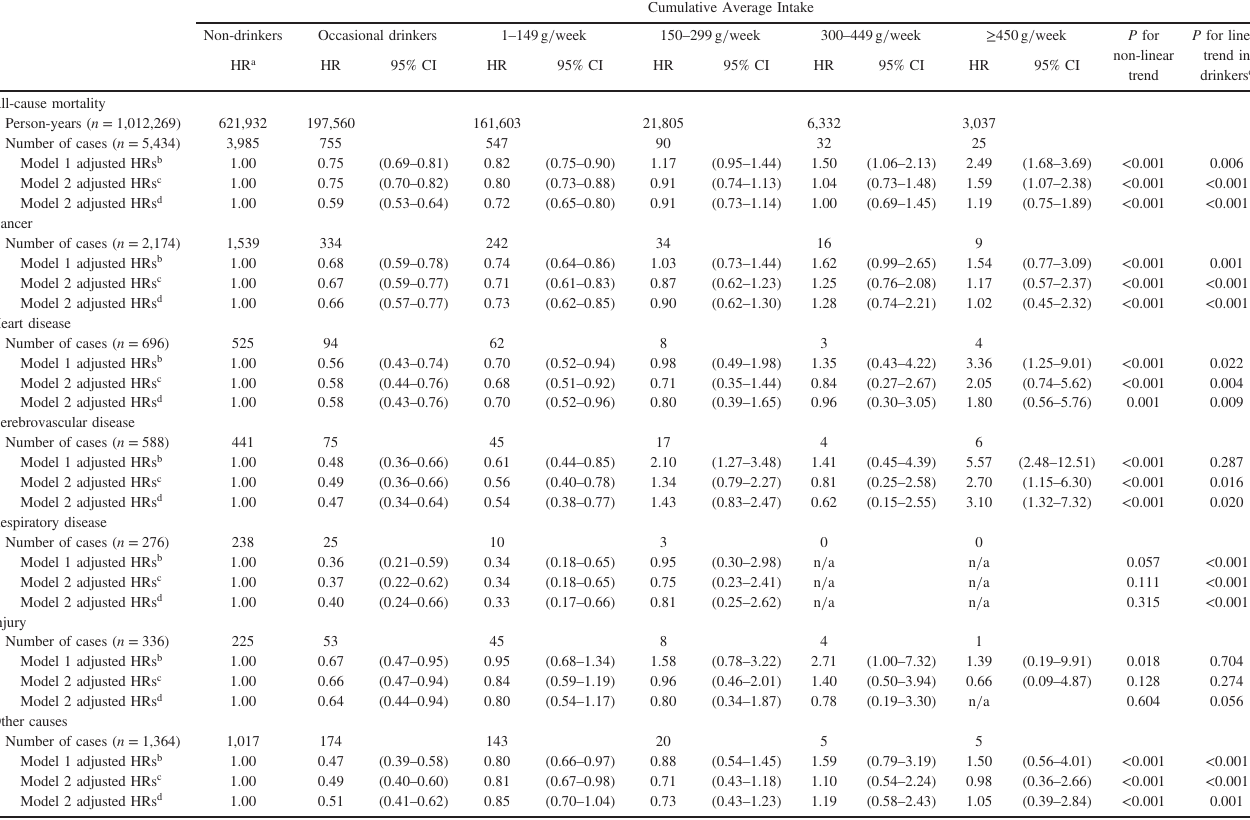
Table 3. Adjusted hazard ratios of mortality by alcohol consumption status